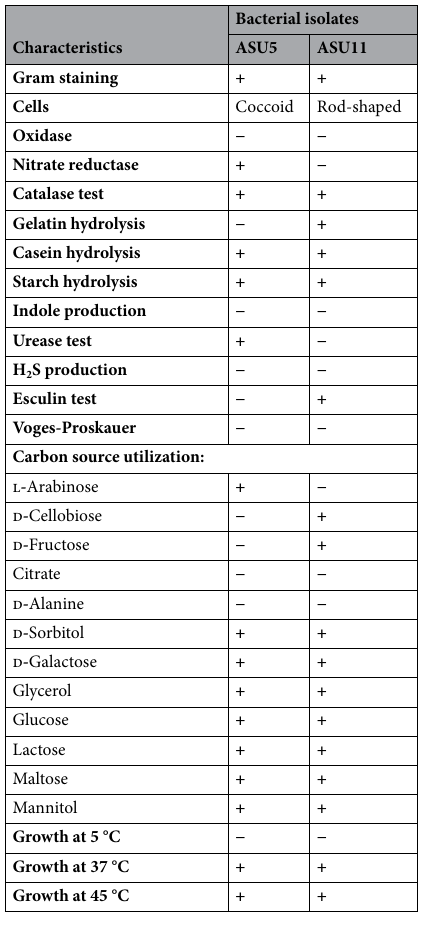
Table 3. Phenotypic characterization of methanol-tolerant and highly lipase-producing bacterial isolates.